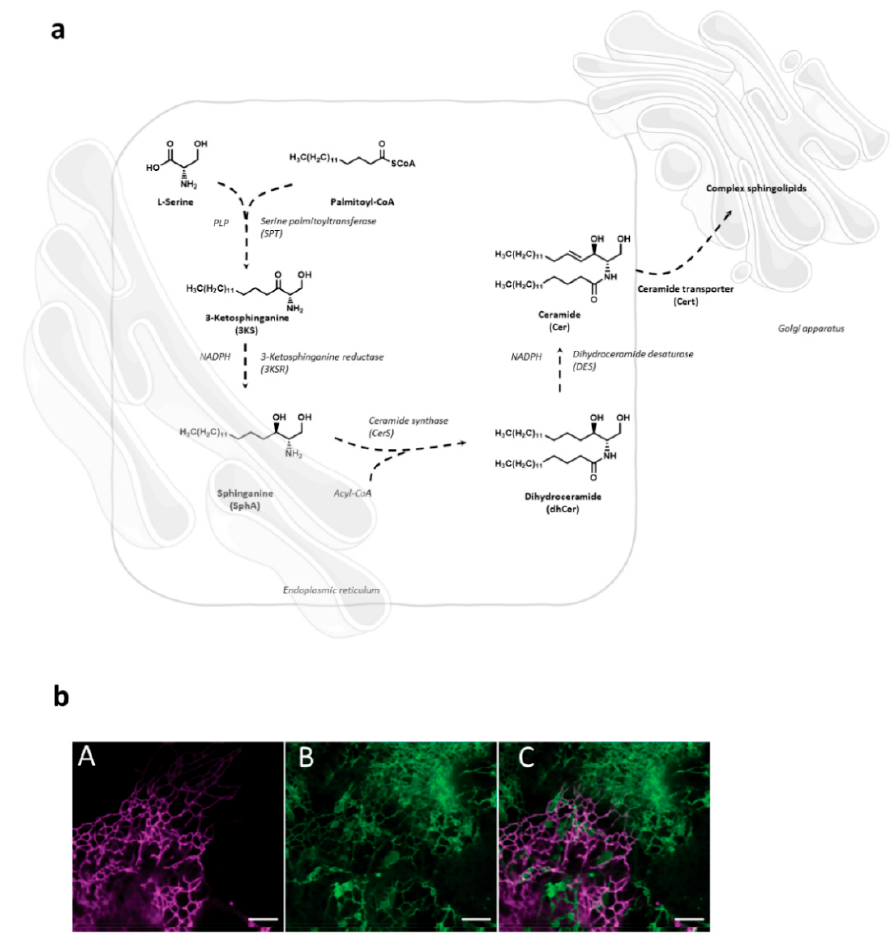
Figure 1. ( a ) Schematic overview of the SL de novo synthesis located in the ER. A cell-free assay utilizing rat liver microsomes containing all the enzymes necessary for bottom-up synthesis of ceramides can be used to study the entire de novo pathway via mass spectrometry [28]. The pyridoxal 5 ′ -phosphate (PLP)-dependent enzyme serine palmitoyltransferase (SPT) catalyzes the condensation of palmitoyl-CoA and L -serine. The product of this reaction, 3-ketosphinganine (3KS), is further NADPH-dependently reduced to sphinganine (SphA) by 3-ketosphinganine reductase (3KSR). Ceramide synthases (CerS) couple fatty acyl-CoAs to the amino group of SphA. This leads to the formation of dihydroceramides (dhCer), differing in the chain length of the amide-bound fatty acid. The final step is the introduction of a double bond between carbons C-4 and C-5 mediated by dihydroceramide desaturase (DEGS) under NAD[P]H consumption. The formed ceramides (Cer) are subsequently shuttled to the Golgi apparatus via ceramide transporter (Cert) for further sphingomyelin synthesis. Parts of the image were taken from https://smart.servier.com, accessed on 1 May 2021 (freely accessible). ( b ) Visualization of sphingolipid metabolism in the ER via bio-orthogonal click chemistry using azidosphinganine and confocal laser scanning microscopy [27]. COS7 cells were transfected with ( A ) the ER-specific protein Sec61-mApple and incubated with ( B ) azidosphinganine and labelled with BODIPY-PEG 4 -DBCO. ( C ) Merged image showing good co-localization of both molecules in tubules of the ER. In contrast to Sec61, azidosphinganine also labelled homogenous structures between ER tubules which might represent ER sheets. Scale bar: 5 µ m